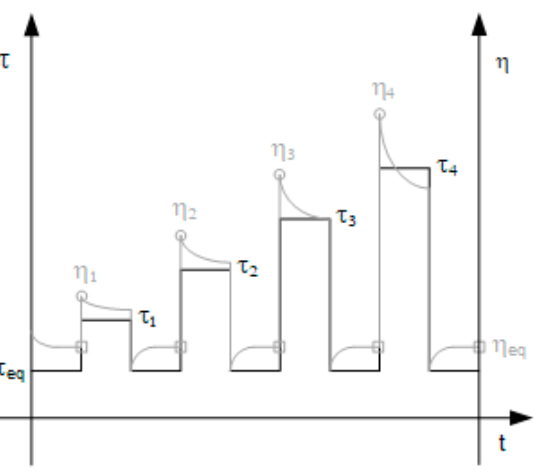
Figure 5. Schematic representation of step changes in a shear stress experiment to obtain constant structure curves of the suspension.